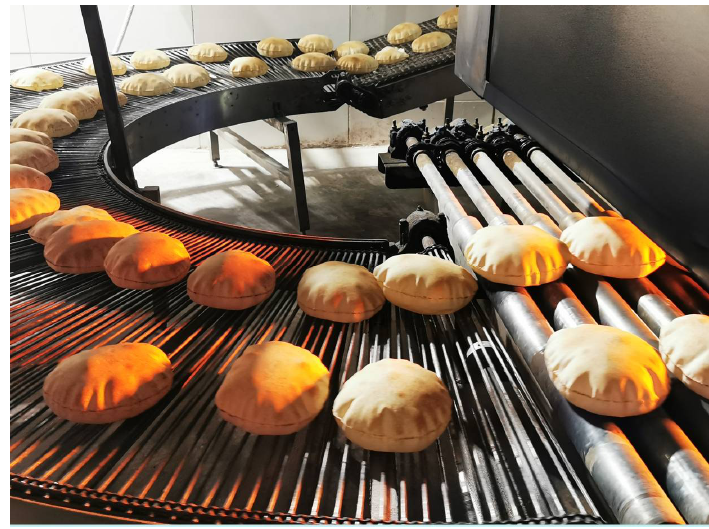
Figure 3. Jordan Kmaj in an automatic baking line. The inflation of bread due to the thermal expansion of the gases is clearly visible.